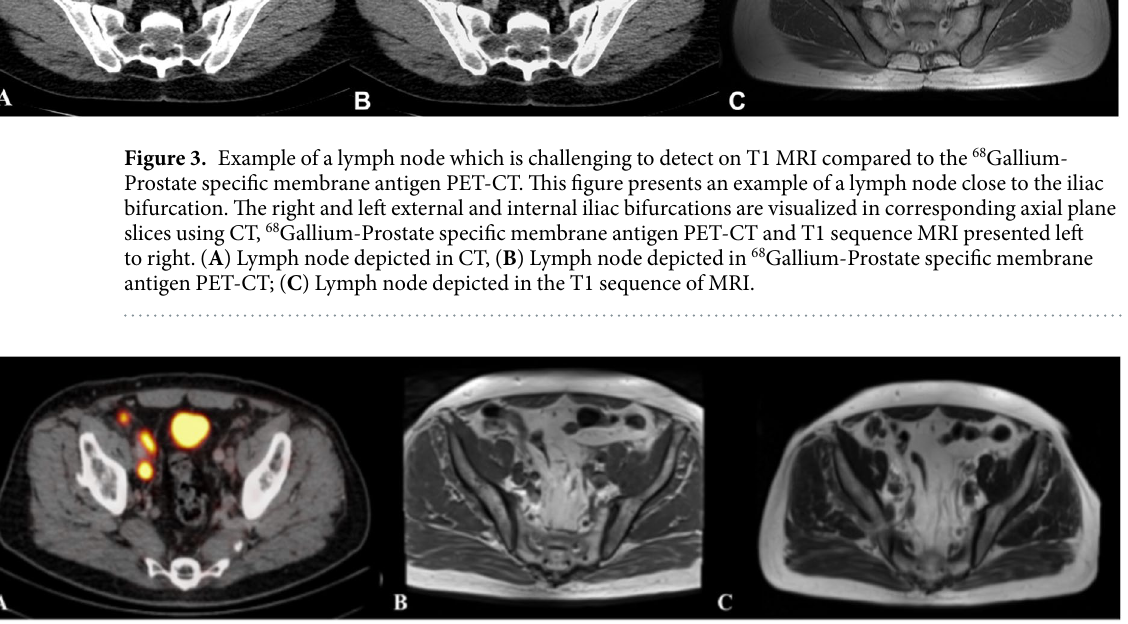
Figure 4. Lymph node evaluation depicted in 68 Gallium-Prostate specific membrane antigen PET-CT and multiparametric MRI. This figure shows an example of lymph node (LN) detection using multiparametric MRI. The lymph node is visualized in corresponding axial plane slices using 68 Gallium-Prostate specific membrane antigen PET-CT, T1 and T2 sequences of MRI presented left to right. The additional use of the T2 weighted sequence improved the detection of a LN in risk to be missed. This suspect LN is located at the right external iliac artery and is challenging to depict in the T1 sequence. ( A ) Lymph node depicted in 68 Gallium-Prostate specific membrane antigen PET-CT, ( B ) Lymph node depicted in the T1 sequence in MRI; ( C ) Lymph node depicted in the T2 sequence in